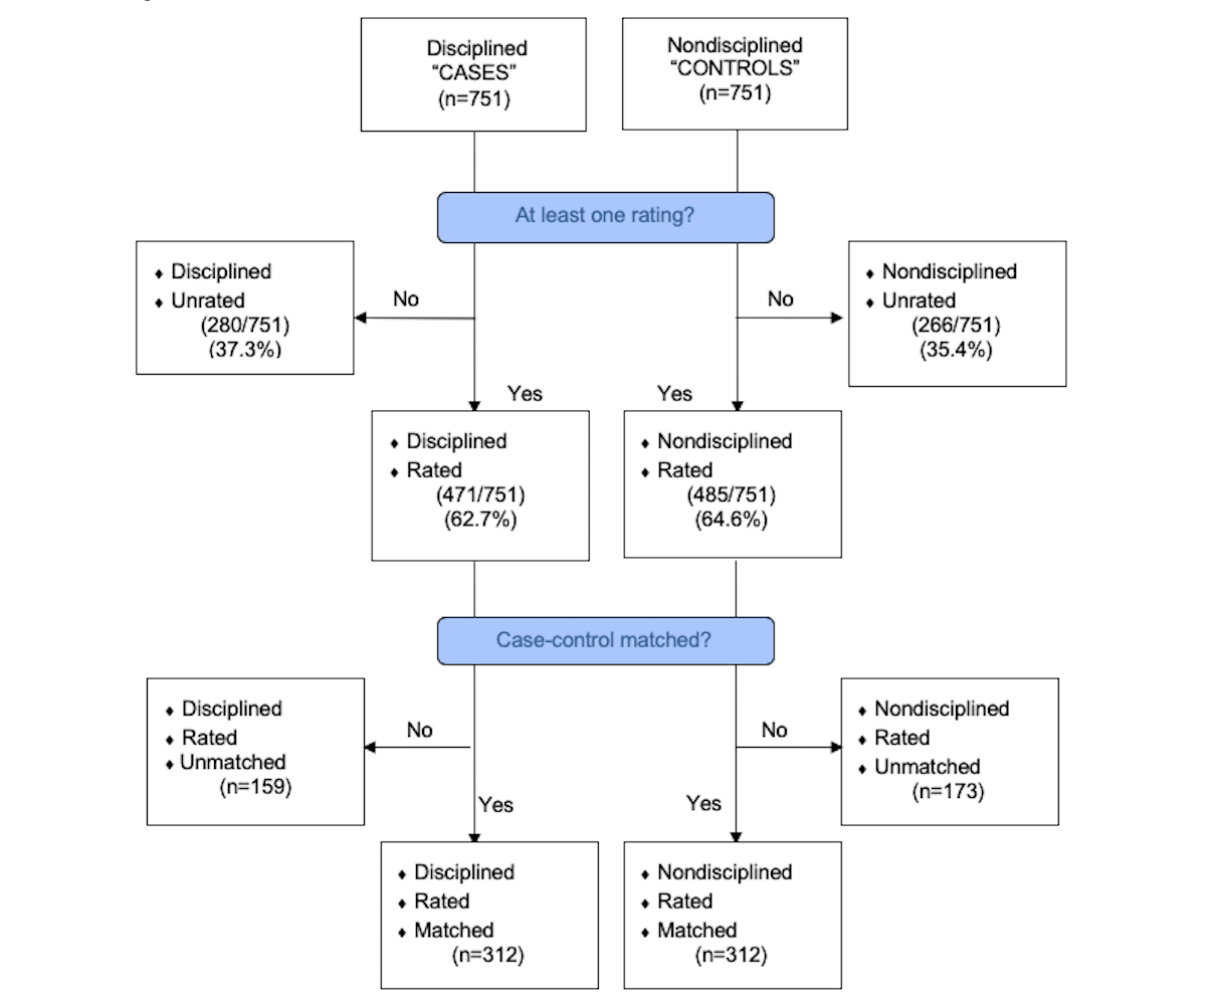
Figure 1. Flow chart for developing matched case (disciplined) and control (nondisciplined) groups of physicians, according to the presence of at least one web-based